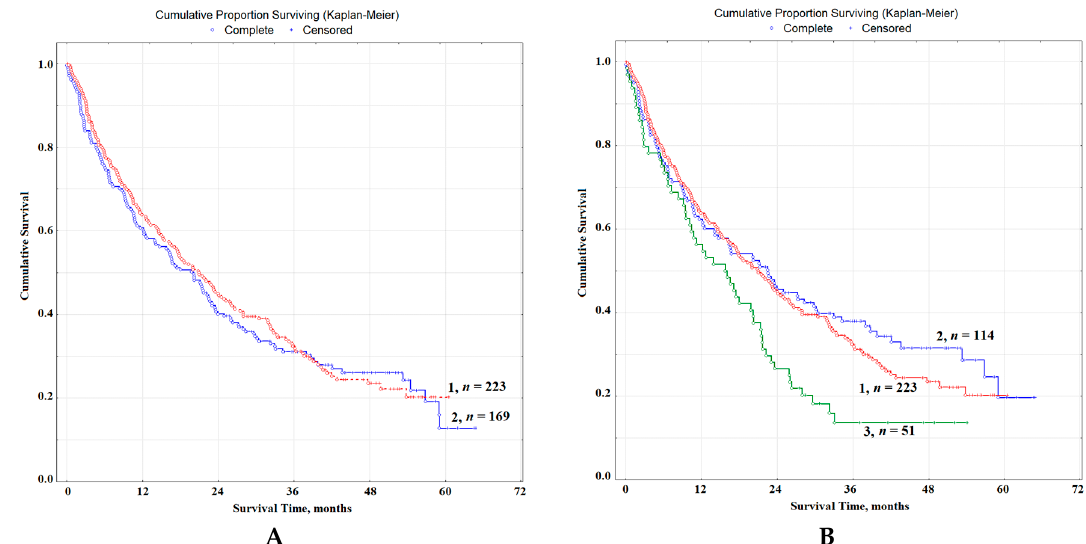
A B Figure 4. Overall survival of patients with lung cancer: ( A ) without COPD (curve 1) and in the presence Figure 4 of COPD (curve 2); ( B ) without COPD (curve 1), lung cancer with COPD I (curve 2) and lung cancer with COPD II (curve 3). n is the number of patients in each